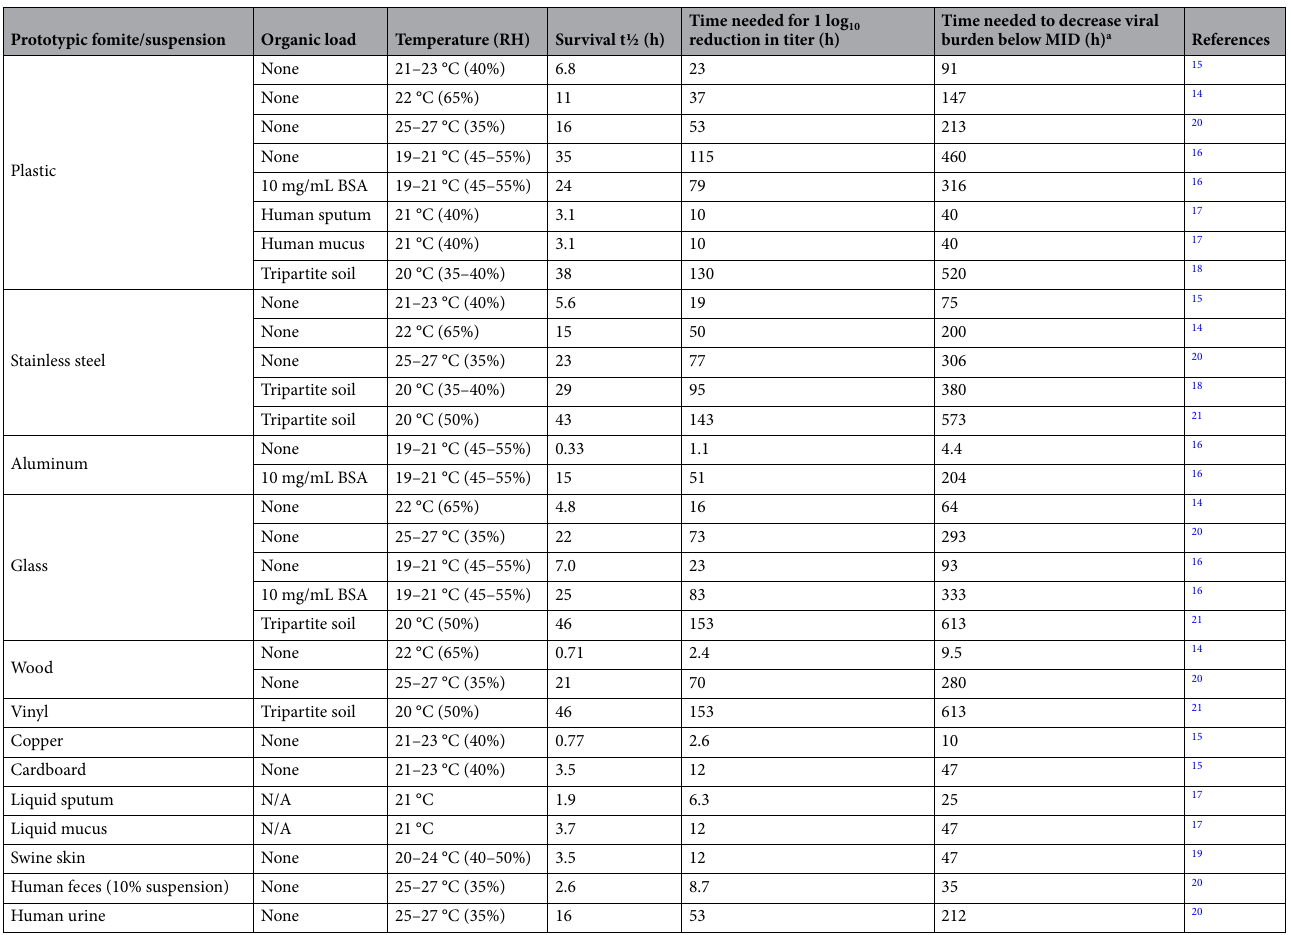
Table 1. Literature values for terminal survival half-life (t½) of SARS-CoV-2 on prototypic HITES, on skin, or in suspension. Abbreviations used: BSA, bovine serum albumin; MID, human minimal infectious dose; RH, relative humidity; t½, half-life. a Calculated assuming an initial deposited virus burden of 1.0 × 10 6 plaque- forming units (PFU) and an estimated human MID of 250 PFU (see “Methods” section).